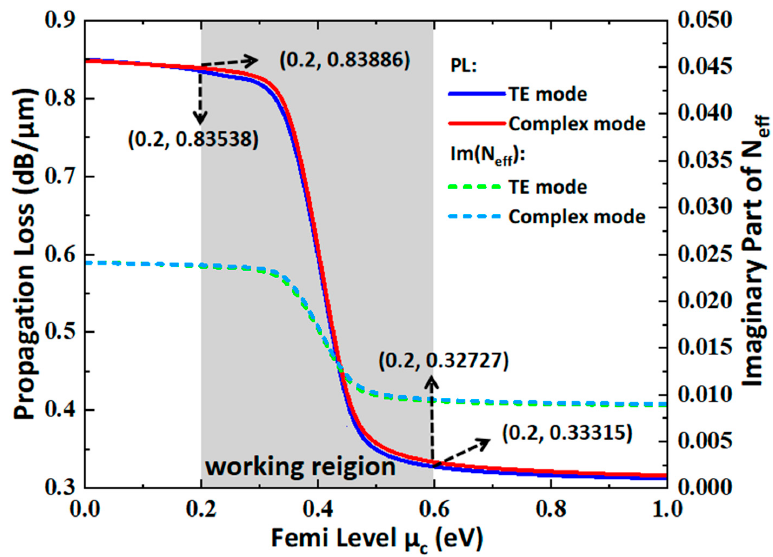
Figure 17. PL and Im( N eff ) of TE mode and complex mode versus Femi level, µ c